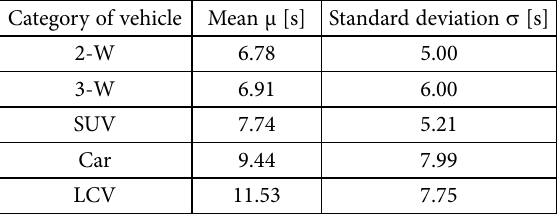
Table 3. SD statistics for different categories of vehicles